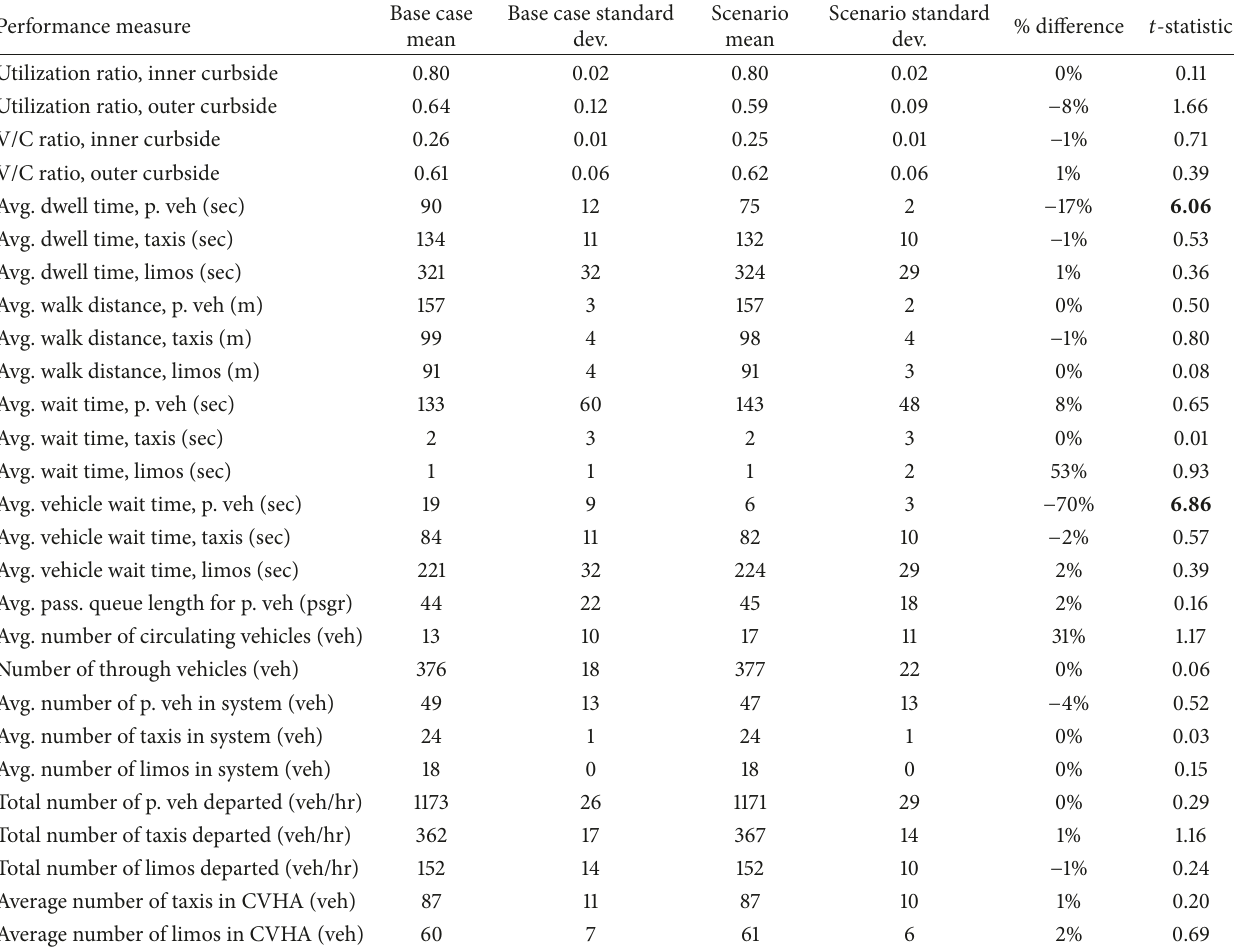
Table 7: Results for increased enforcement scenario (bold cells indicate that result is significantly different from the base case). Performance